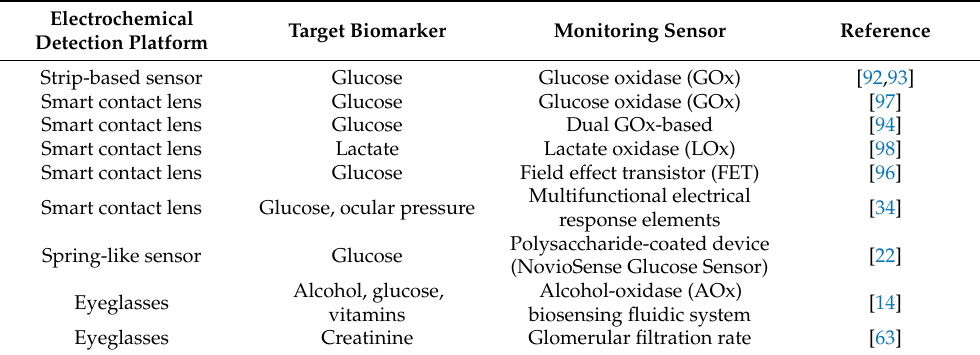
Table 2. Emerging applications of tear-based electrochemical detection platforms and target biomark-